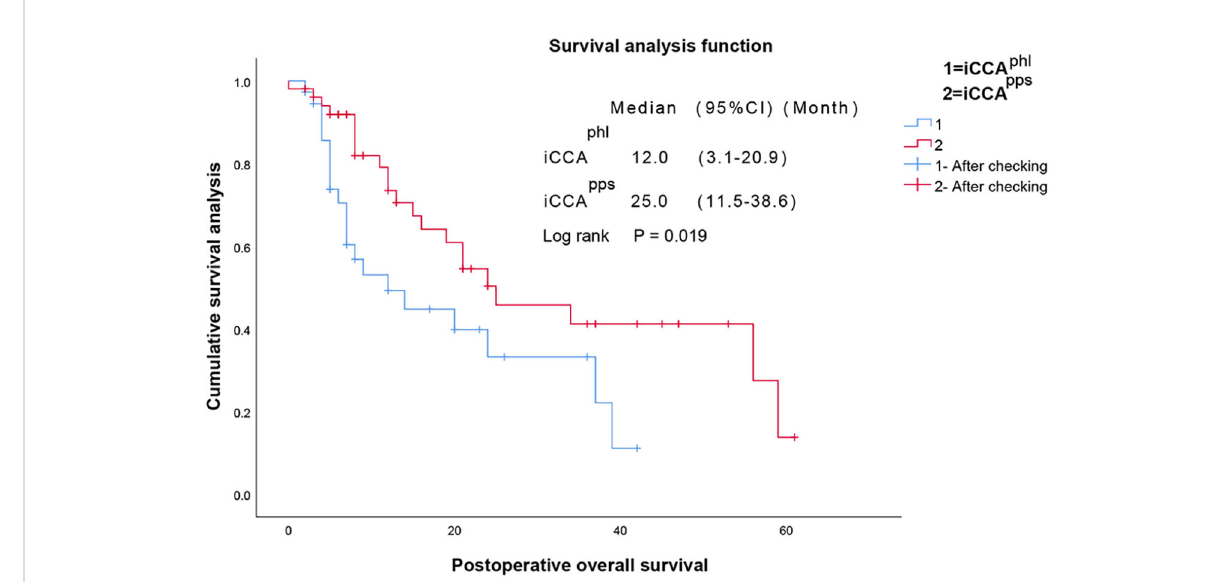
FIGURE 3 Pairwise comparison of the overall survival between the two types of intrahepatic cholangiocarcinoma. iCCA phl , perihilar large duct type of intrahepatic cholangiocarcinoma; iCCA pps , peripheral small duct type of intrahepatic cholangiocarcinoma; M [95% CI], median [95% con fi dence interval].